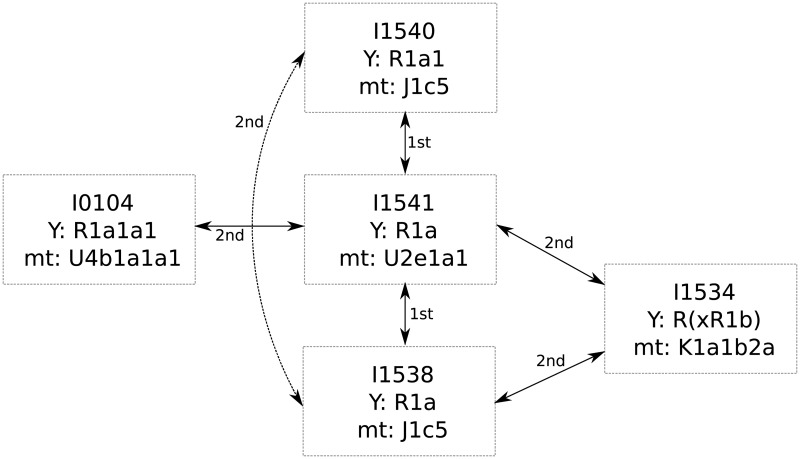
Kin-relationship among males at the Corded Ware site in Esperstedt, Germany.The five individuals, their inferred degree of relationship and their uniparental haplogroups. The dashed line between I1540 and I1538 shows a second degree relationship missed by READ.